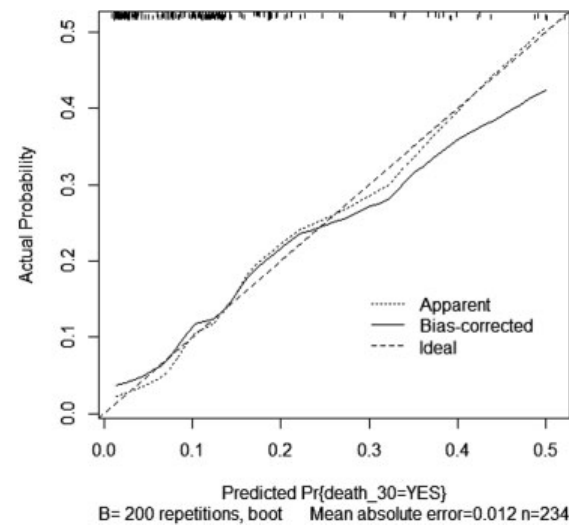
Fig. 1 Plasma levels of D-dimer in the four ESC risk classes (low, intermediate-low, intermediate-high, and high). Data are reported as median values, interquartile ranges (boxes), and 2.5th and 97.5th percentiles (whiskers).